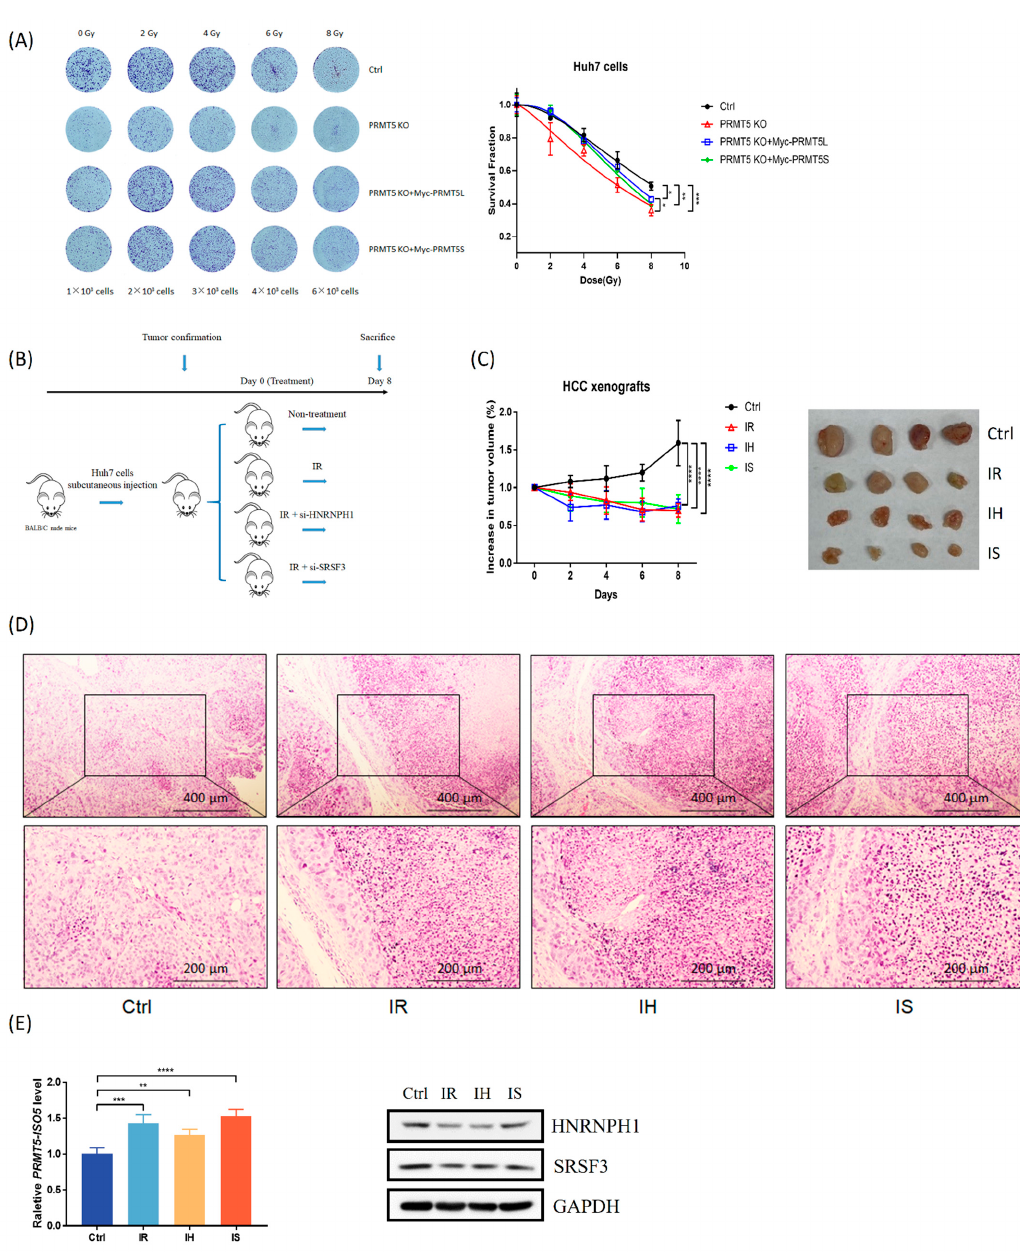
Figure 5. The increase in PRMT5-ISO5 levels suppresses cell proliferation and inhibits tumor growth. ( A ) Left panel: the cell colony-forming abilities of cells treated with IR. Right panel: the survival frac- tion according to the calculation of colonies. Ctrl: Cas9-positive Huh7 cells; PRMT5 KO: PRMT5 KO Huh7 clones; PRMT5 KO + Myc-PRMT5L: PRMT5 KO Huh7 clones with exogenous expression of full-length PRMT5; PRMT5 KO + Myc-PRMT5S: PRMT5 KO Huh7 clones with exogenous expression of truncated PRMT5. ( B ) The procedure of the HCC xenograft model and treatments (n = 4 for each group). ( C ) Left panel: the volume of HCC xenograft tumors after treatment was normalized by the control group (n = 4 in each group). Right panel: tumors dissected from mice at the 8th day post-treatment. ( D ) The morphological change in HCC xenograft tumors at the 8th day post-treatment (100 × and 200 × ). ( E ) Left panel: PRMT5-ISO5 transcriptional level of HCC xenograft tumors at the 8th day post-treatment (n = 4 in each group). Right panel: HNRNPH1 and SRSF3 expression level of HCC xenograft tumors at the 8th day post-treatment (n = 4 in each group). Ctrl: HCC xenograft tumors without further treatment; IR: HCC xenograft tumors with IR treatment; IH: HCC xenograft tumors with IR treatment and in vivo si-HNRNPH1 intratumoral injection; IS: HCC xenograft tumors with IR treatment and in vivo si-SRSF3 intratumoral injection. ** p < 0.01, *** p < 0.001, **** p <